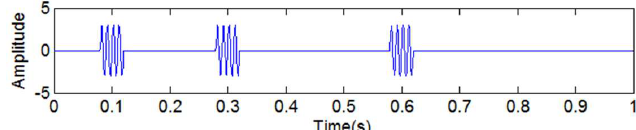
Figure 13. The simulated discontinuous high-frequency signal y 8 ( t ).